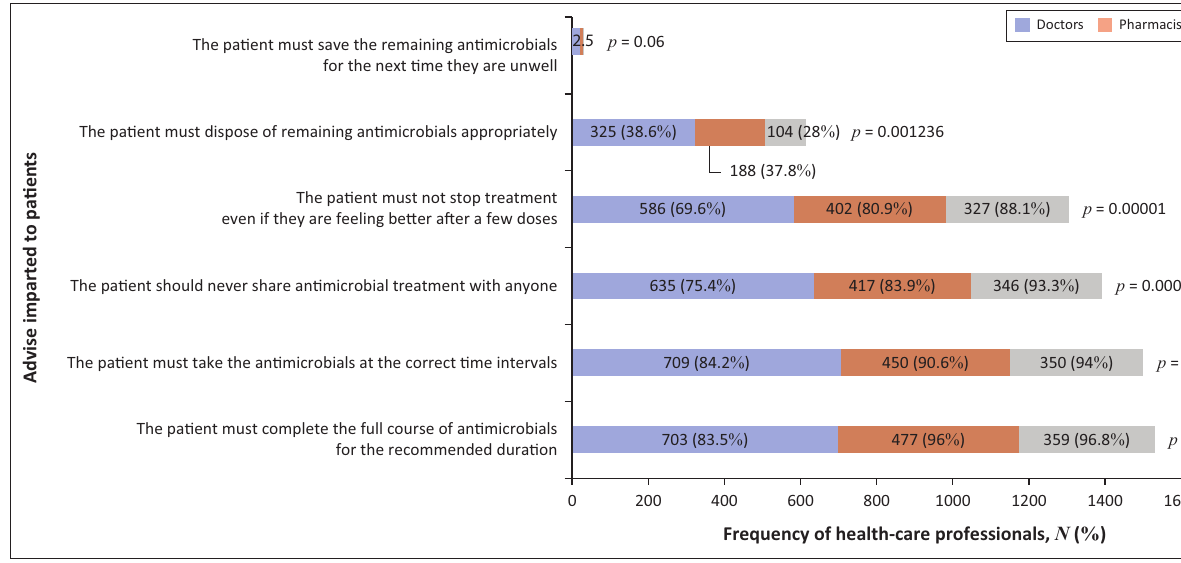
FIG URE 4: Advice imparted by healthcare professionals to patients on antimicrobial